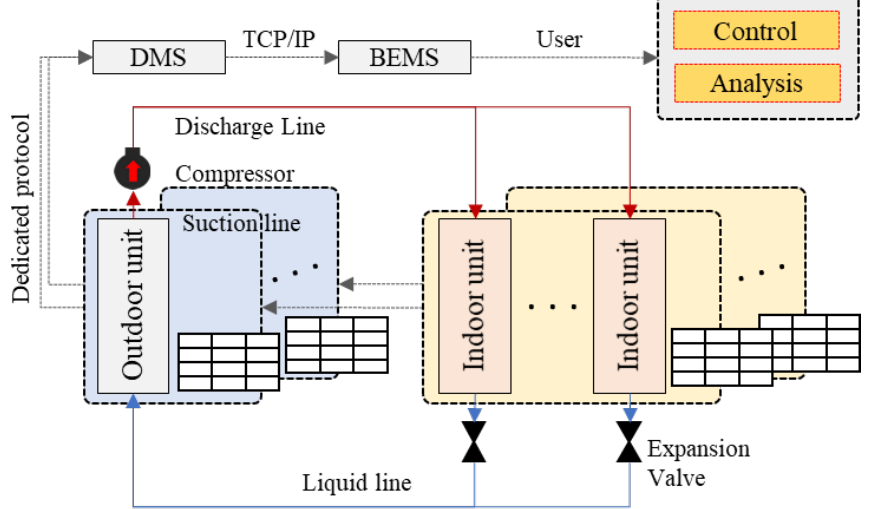
Figure 3. On-site data acquisition process. Table 1. Existing data and experiments.